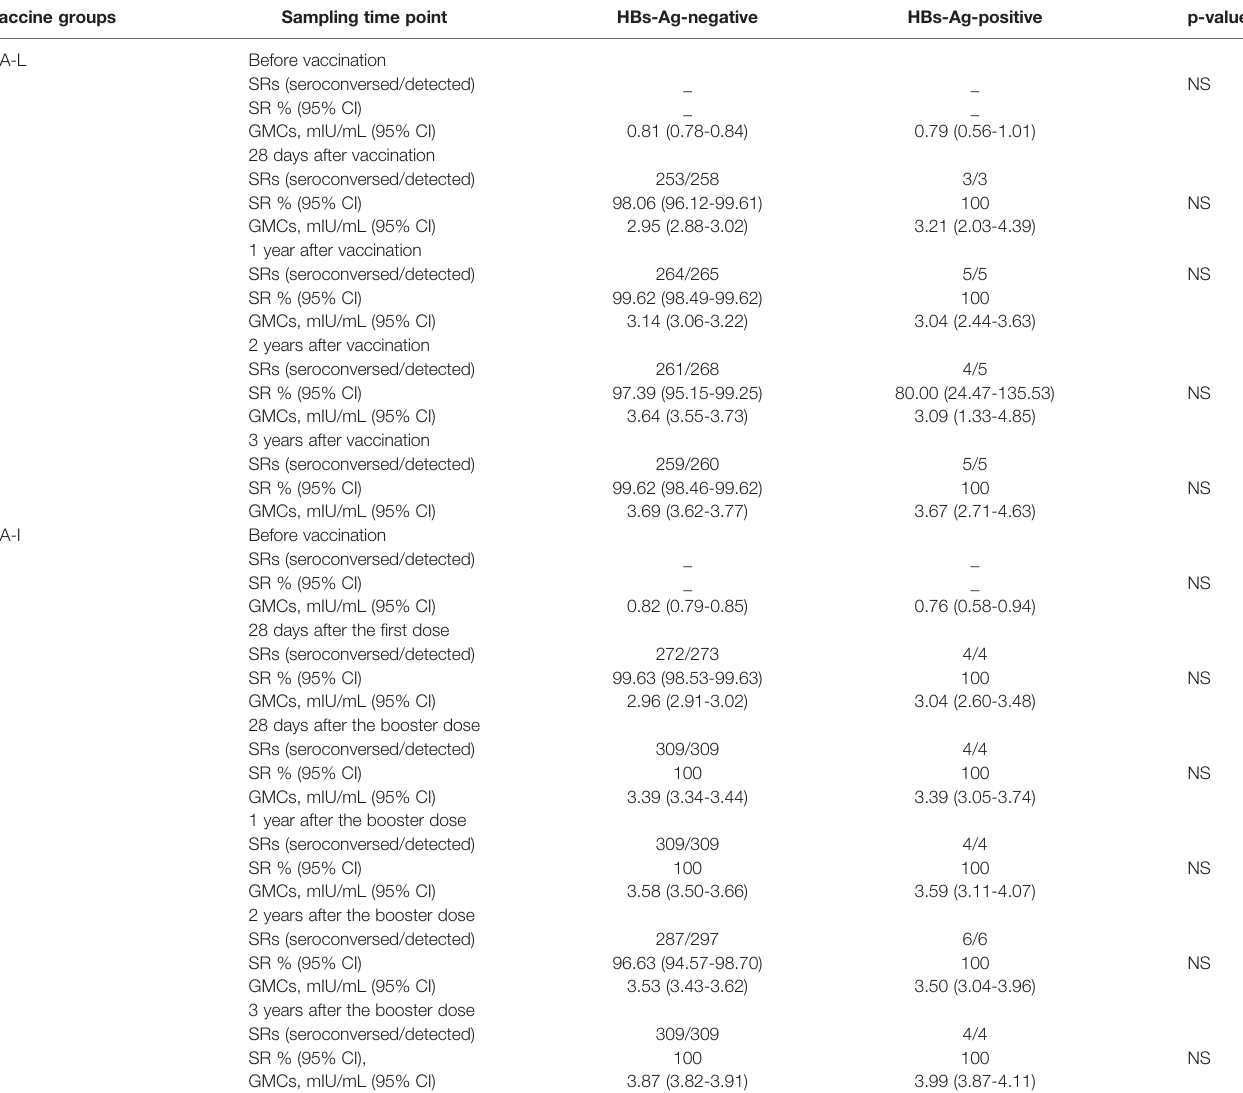
TABLE 3 | The immunogenicity and immunopersistence of HA vaccines in HBs-Ag-positive participants. Vaccine groups Sampling time